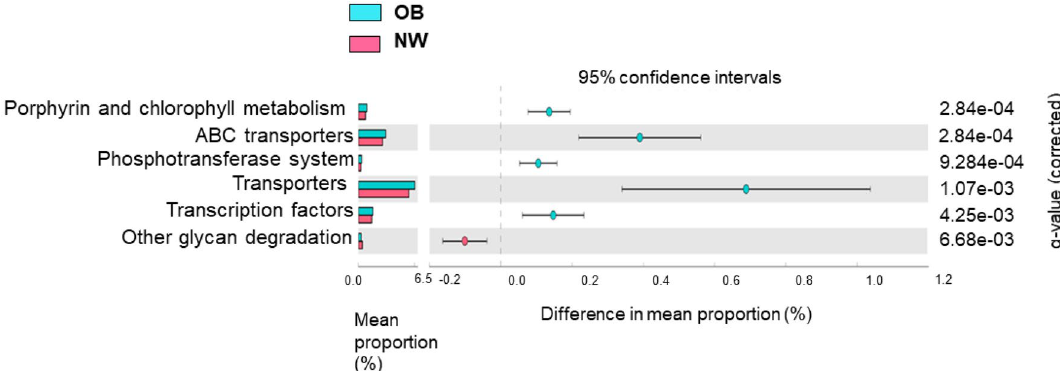
Figure 6. Statistically significant differences in predicted metabolic pathways between OB and NW. Phylogenetic Investigation of Communities by Reconstruction of Unobserved States (PICRUSt) algorithm was performed on Galaxy software v.1.0. (https ://galax y.morga nlang ille.com/) to infer metagenome composition in the samples by analyzing OTUs generated by QIIME pipeline. Bacterial metabolic pathways were predicted and classified by Kyoto Encyclopedia of Genes and Genomes (KEGG). Statistically differences were analyzed for all metabolism pathways using the Statistical Analysis of Metagenomic Profiles (STAMP) software. Pathways more abundant in OB are on the positive side (light-blue circle with 95% CI); pathways less abundant in OB are on the negative side (pink circle with 95% CI). The statistical significance was tested using Welch’s test, with a Storey False Discovery Rate (FDR) correction. q equal to or less than 0.05 was considered statistically significant. Mean proportions are shown in stacks (OB = light- blue; NW = pink). The difference in mean proportions indicates the mean proportion OB minus the mean proportion